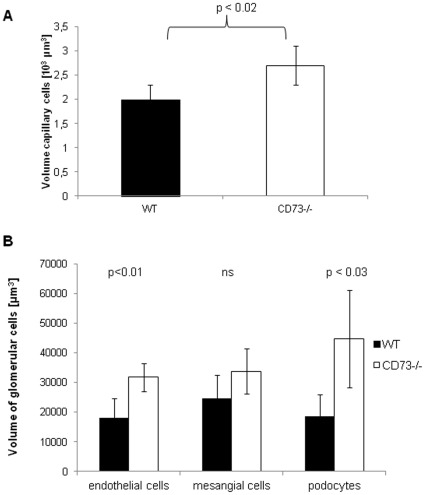
CD73−/−mice show an increased volume of podocytes, glomerular endothelial cells and capillaries.Five sections per animal were analyzed using the point-counting method and a 100-point-eyepiece (integration plate II, Zeiss Co.) at a magnitude of 100× (oil immersion). (A) Volume of glomerular capillaries in 103 µm3 in CD73−/−mice as compared to WT (n = 5−6, means ± SD, p<0.02 according to Student t-test.). (B) Volume of glomerular cells in [µm3] CD73−/−mice as compared to WT (n = 5−6, means ± SD, p<0.01 according to Student t-test.).